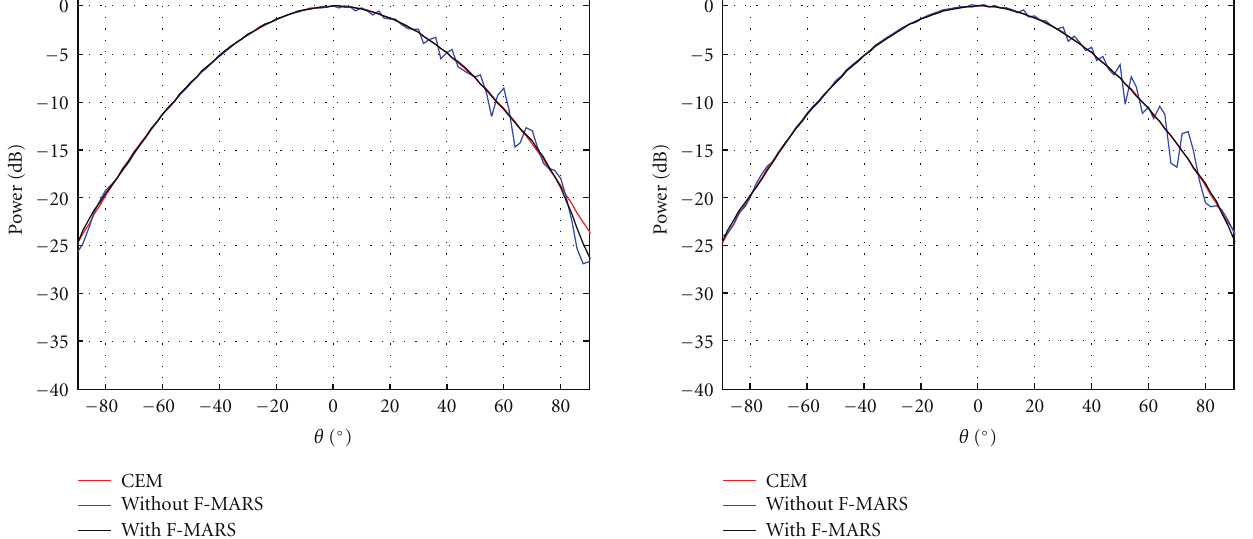
Figure 10: Far-field cut with and without MARS processing. Dis- placement of 30 cm.